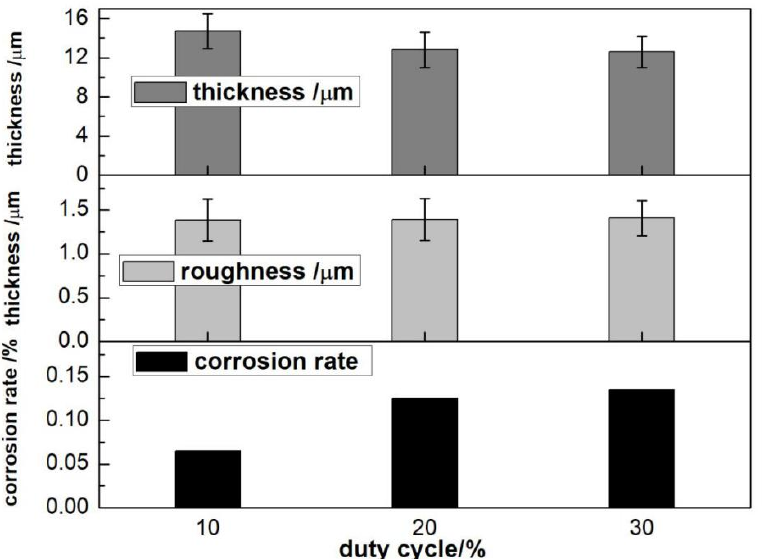
Figure 5. The values of corrosion rate, roughness and thickness at different duty cycles. Electrolyte compositions: 45 g/L NaOH, 50 g/L Na 2 SiO 3 , 90 g/L Na 2 B 4 O 7 . Electrical parameters: current density 1 A/dm 2 ; oxidation time 10 min; pulse frequency 100